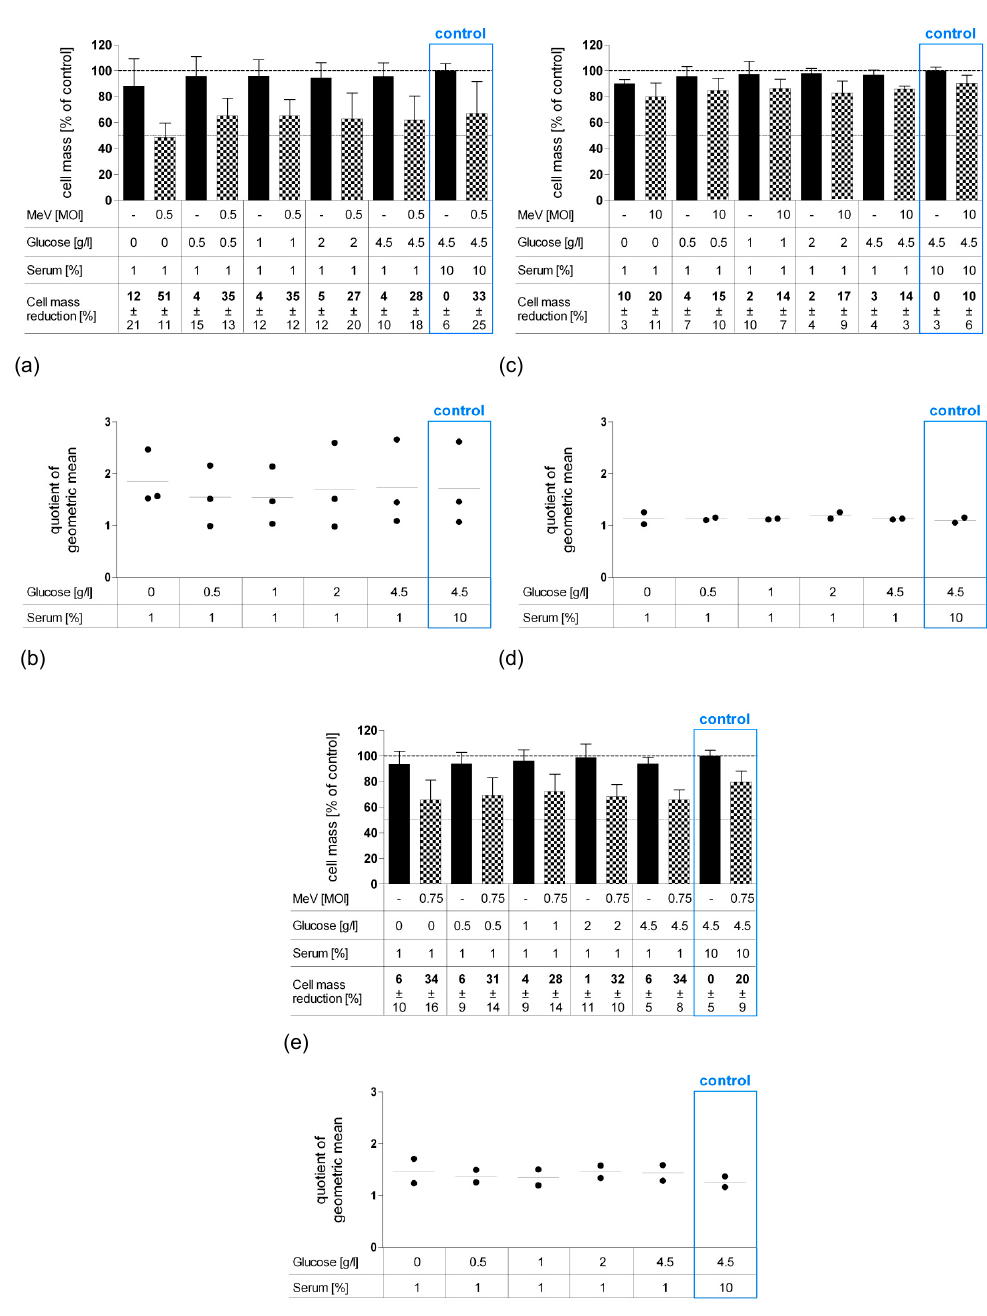
Figure 3. E ff ect of short-term pre-infection starvation (24 h) on MeV-mediated oncolysis in HT-29 ( a , b ), HCT-15 ( c , d ) and HCT-116 ( e , f ) cells. Short-term starvation and MeV infection of neoplastic HT-29, HCT-15, and HCT-116 cells (human colon carcinoma) were performed according to Figure 1a. At 96 hpi, the remaining tumor cell masses were determined by SRB assay. ( a , c , e ) Black bars represent MOCK-infected tumor cells (addition of Opti-MEM only, no infectious virus particles); checkered bars display tumor cells infected with MeV. Means and SEM of three or two independent experiments are shown; control: tumor cell cultures and infections performed under standard medium conditions (no starvation). ( b , d , f ) The impact of starvation on the virus-mediated oncolysis efficacy was evaluated by comparing the ratios of uninfected (MOCK) and virus-infected groups (VIRUS) between starving and standard medium conditions (control). Statistical analysis was performed using the Dunnett’s multiple comparison test. Each dot represents one run of the experiment; horizontal lines represent means of quotient of geometric mean